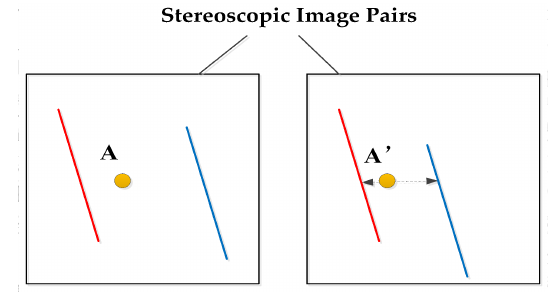
Figure 9. Edge line feature